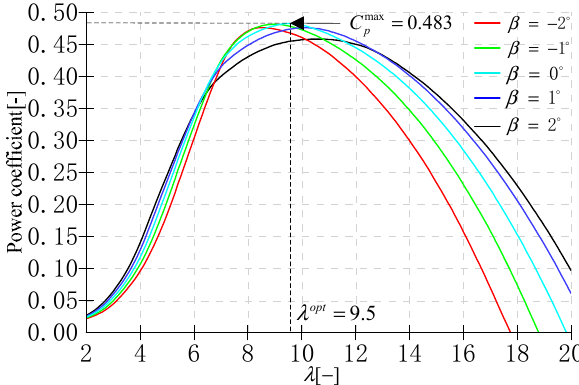
Figure 2. Aerodynamic power coefficient curves of the concerned WT under different β and λ